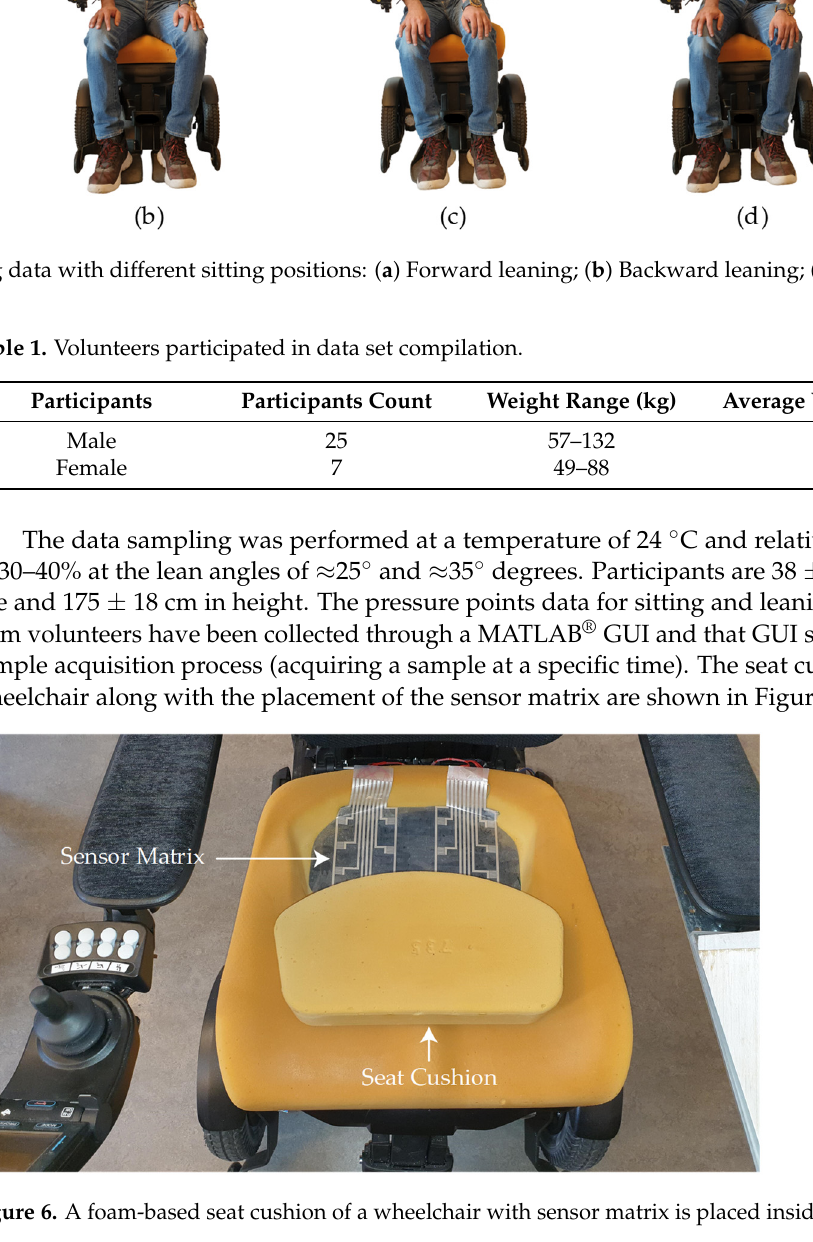
Figure 6. A foam-based seat cushion of a wheelchair with sensor matrix is placed inside the cushion.